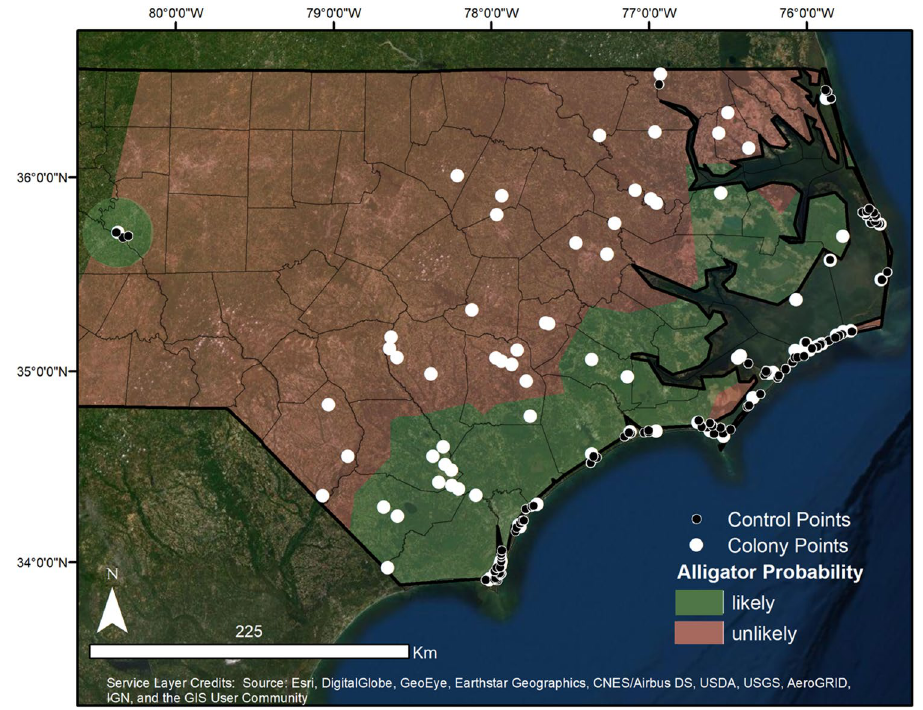
Figure 1. Map of the study area with locations for all wading bird colonies and control islands included in the analysis and the general alligator probability assignments throughout North Carolina. Solid white circles represent colony locations (island and mainland colonies) and small black circles represent available colony islands. Green blocks are areas where alligator occurrence is likely and red blocks are areas where alligator occurrence is unlikely. Note that available colony islands were only created for island colonies. Map generated in ESRI ArcMap 10.6 83 (http://www.esri.com/). Main map satellite imagery is the World Imagery basemap within ArcGIS 10.6 software (http://www.esri.com/data/basem aps), see Service Layer